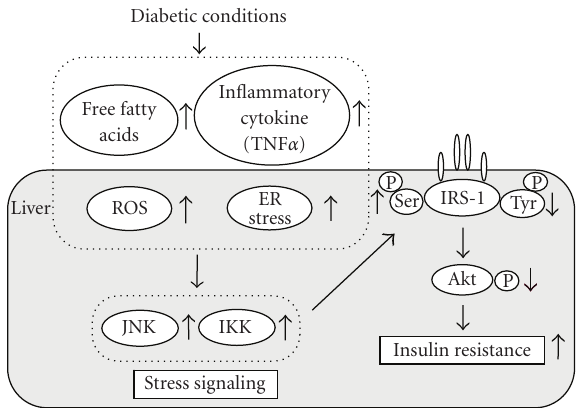
Figure 3: Role of ROS in the development of insulin resistance in type 2 diabetes. The JNK pathway is activated by various factors such as ROS, ER stress, free fatty acids (FFAs), and inflammatory cytokines such as TNF α and is involved in the development of insulin resistance found in type 2 diabetes. It has been also shown that the IkappaB kinase β (IKK) pathway is also activated by such factors and is involved in the development of insulin resistance. Therefore, it is likely that activation of stress signaling is involved in the development of insulin